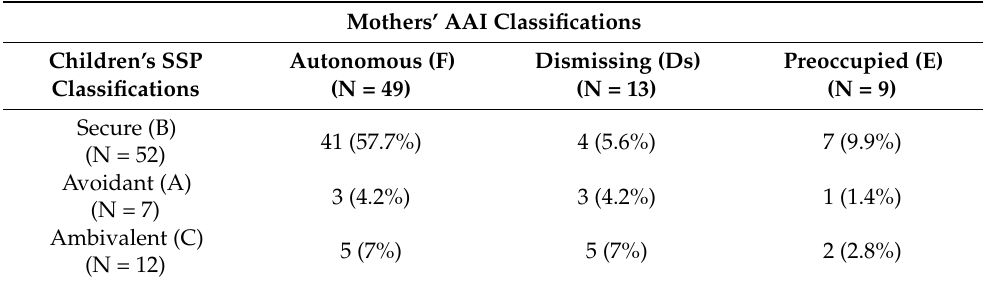
Table 1. Associations between 71 mothers’ prenatal AAI classifications and the SSP classifications of their children at 15 months.